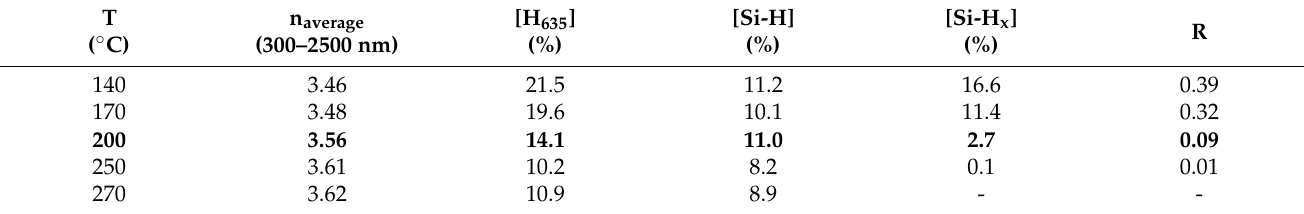
Table 1. Optical and structural properties of a-Si:H(i) films deposited by PECVD with different hydrogen